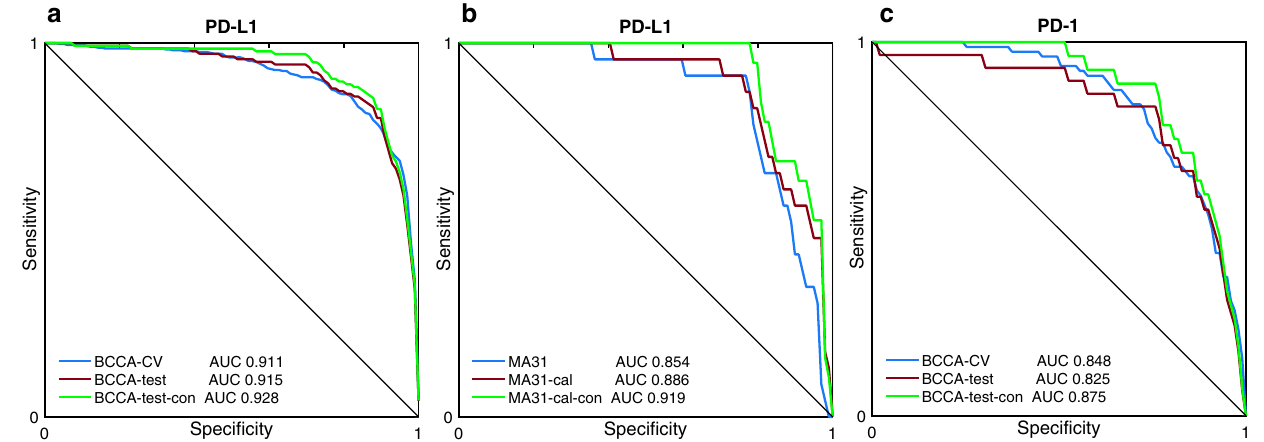
Fig. 2 | Convolutional neural networks achieve high performance in the pre- diction of PD-L1 and PD-1 expression. Receiver operating characteristics (ROC) curvesfortheperformanceoftheproposedmodels,intermsofAUC,forPD-L1and PD-1 prediction in the BCCA and MA31 cohorts. a The model obtained high pre- diction accuracies for both the BCCA cross-validation (0.911) and BCCA test set (0.915). When analyzing only concordant cases between pathologists, AUC per- formance was further increased (0.928). b For the external MA31 cohort, the